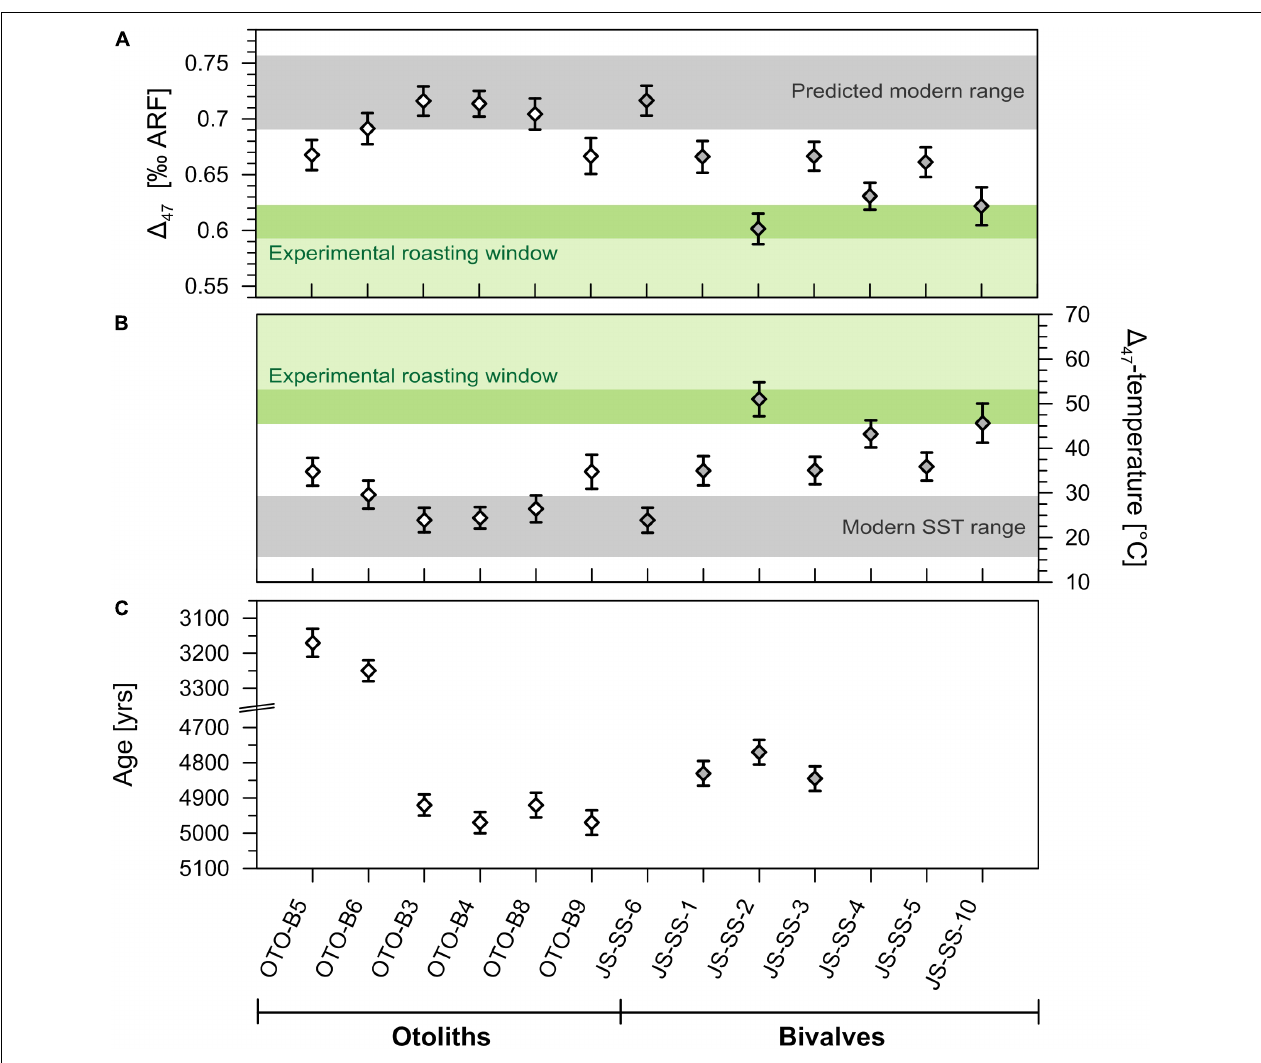
FIGURE 3 | Clumped isotope geochemistry and radiocarbon ages of Holocene specimens. (A) Clumped isotope data of the Holocene otoliths and bivalve shells. Mid-Holocene samples have previously been discussed in Müller et al. (2017). (B) (cid:49) 47 -based water temperatures estimated using the equation of Dennis et al. (2011). Error bars represent average standard errors (SE) of the individual (cid:49) 47 -measurements. The shaded grey areas represent predicted (cid:49) 47 -values in A based on the seasonal SST range from Lavaud et al. (2013) shown in B . Shaded green areas represent the experimental (cid:49) 47 -/temperature windows for prehistoric cooking (roasting at ca. 174 ◦ C) from Müller et al. (2017) for ca. 6 h (light green) and a more realistic cooking duration of > 30 min (dark green). Only very few mid-Holocene shells exhibit (cid:49) 47 values that suggest a potential alteration due to prehistoric cooking practices (roasting), whereas fish otoliths show little indication of significant pre-depositional heating. (C) Radiocarbon ages were calibrated using OxCal 4.3 (Bronk Ramsey, 1995) with the Marine13 calibration curve (Reimer et al., 2013) and a local (cid:49) R value of − 300 years (Müller et al.,